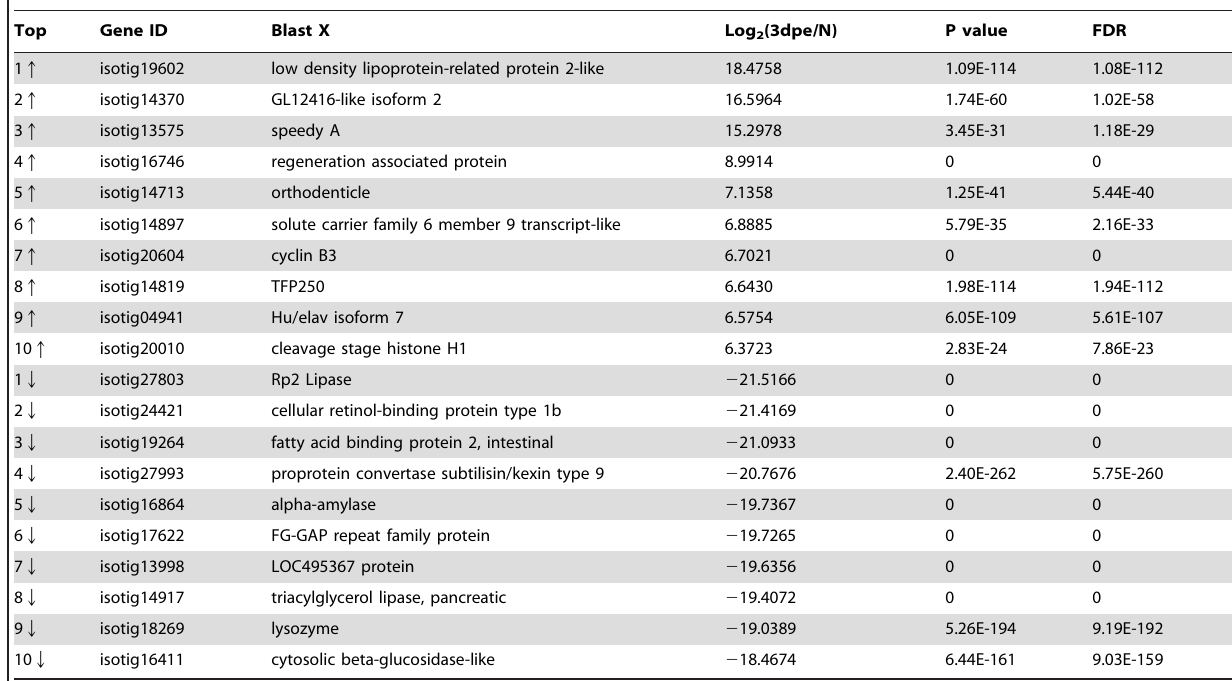
Table 2. Top 10 differentially expressed genes at 3 dpe VS Normal.